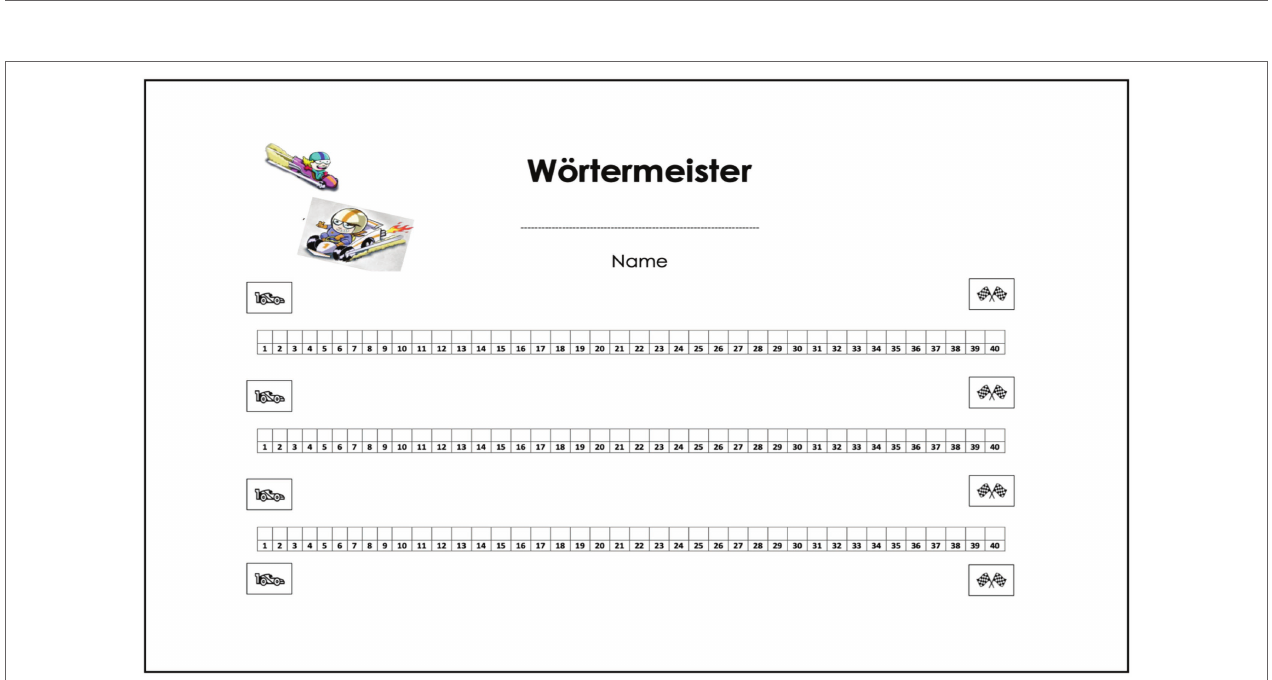
FIGURE 1 | Example part of a story. The secrets of the underwater world. The first day of school. Text: Alvin has a stomach-ache because he is excited. Tomorrow he is supposed to go to school for the first time. Of course, he is looking forward to it. Finally, he belongs to the big kids and is allowed to learn something, but he is also a little